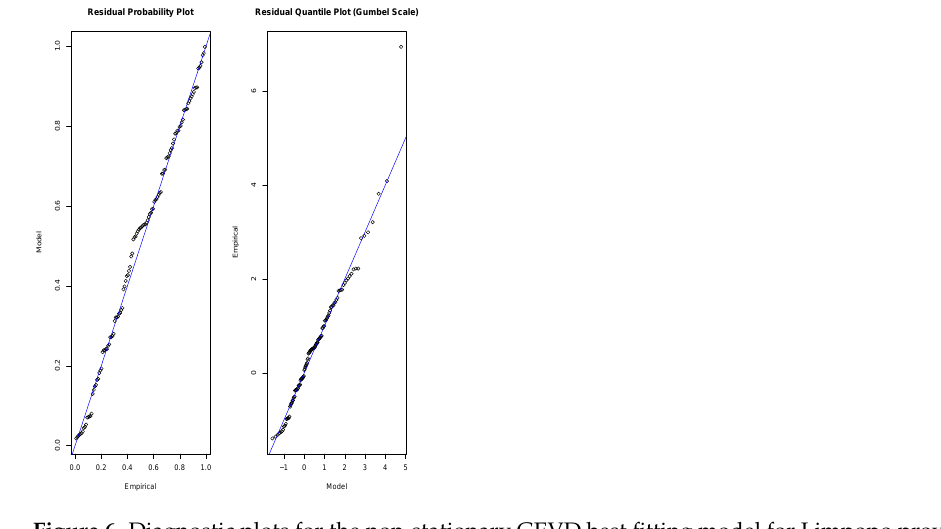
Figure 6. Diagnostic plots for the non-stationary GEVD best fitting model for Limpopo province. Goodness-of-fit test for Limpopo non-stationary GEVD model Kolmogorov-Smirnov (K-S) and Anderson-Darling (A-D) tests were used to determine whether maximum monthly rainfall data for Limpopo follows the non-stationary GEVD model, M 4 . Table 12 presents the K-S and A-D goodness-of-fit tests. From Table 12, the p -value for the K-S test is insignificant ( p > 0.05), implying that